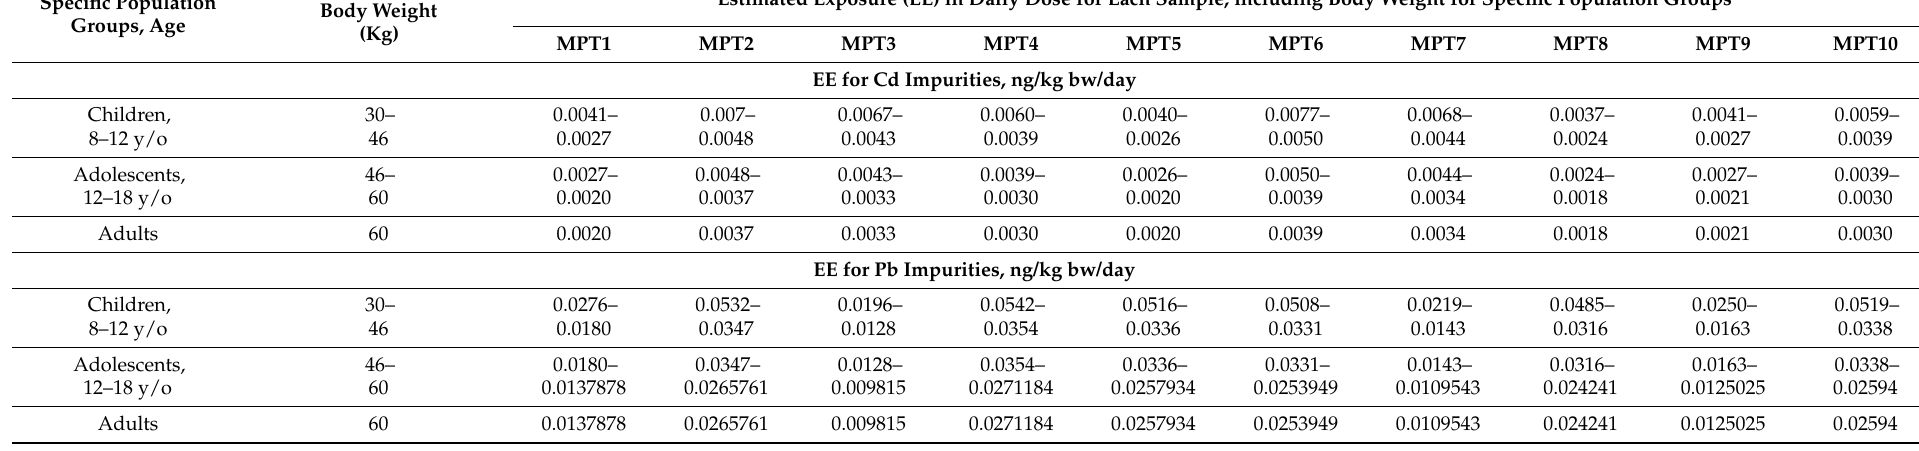
Table 5. The estimated exposure of Cd and Pb in the daily dose for each sample (PMT1–PMT10) depending on age and body weight for each specific population group (ng/kg bw/day).